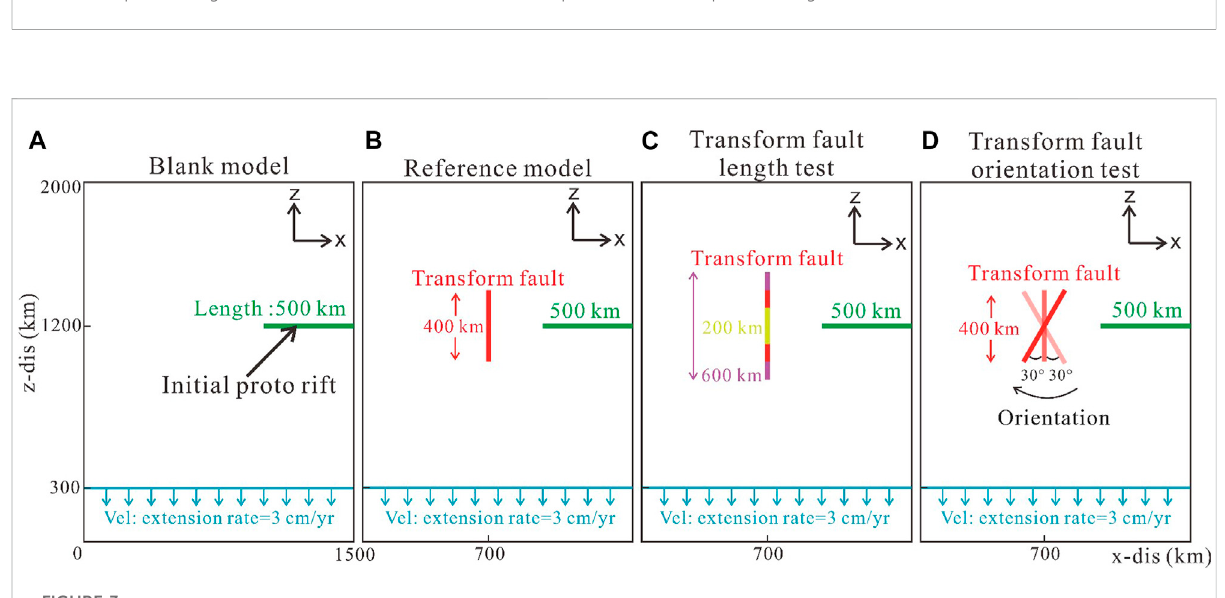
FIGURE 3 Variationsonmodelcon fi gurationinmapview. (A) Blankmodelwithoutpre-existingtransformfaults. (B) Referencemodel (C – D) Modelteston the length and orientation of the transform